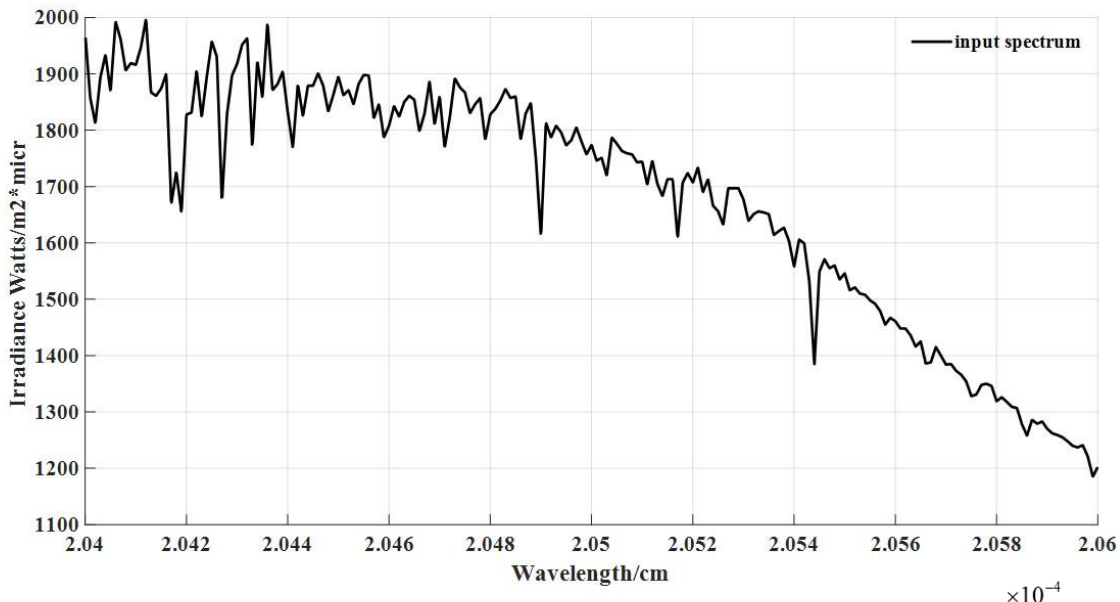
Figure 6. Input spectrum.